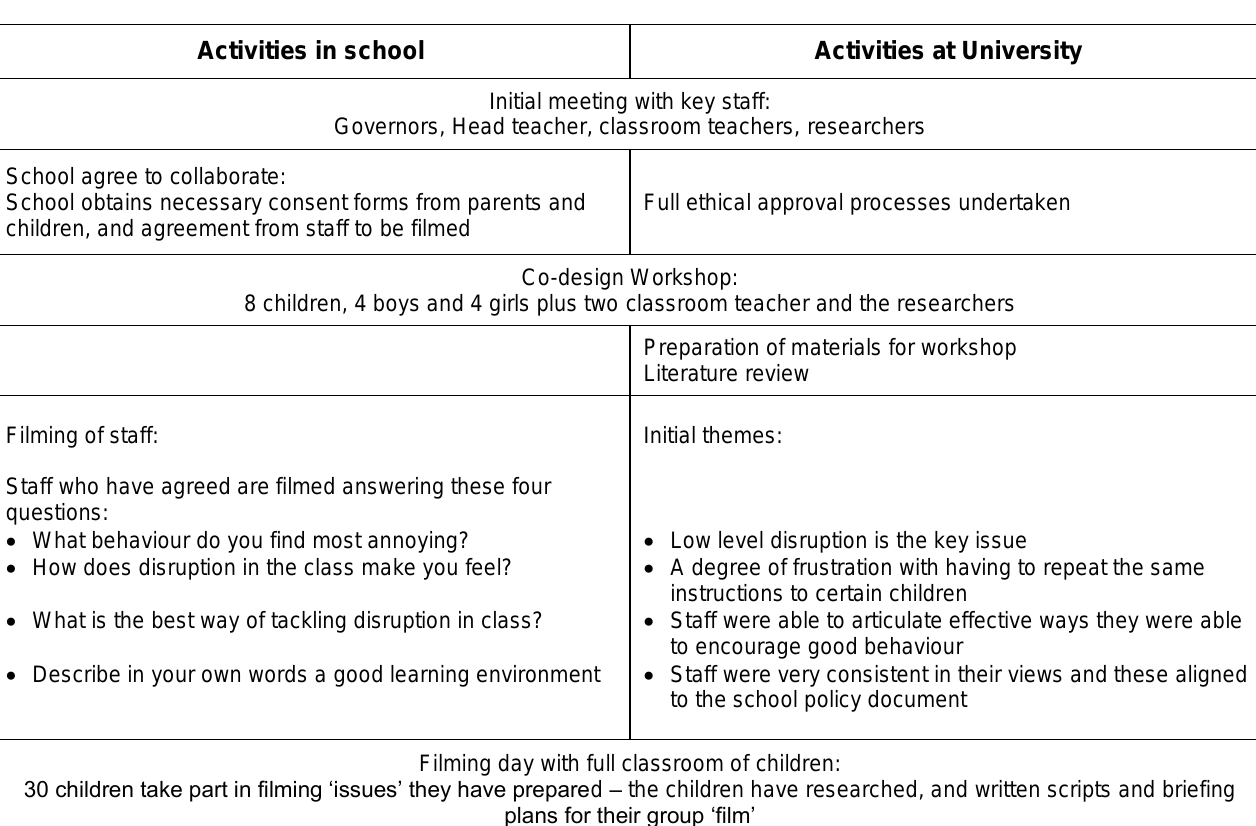
Table 1. The summary of project